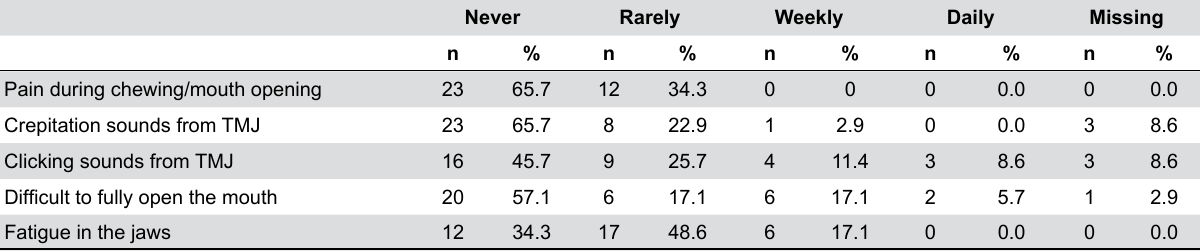
Table 4- Responses to the questionnaire